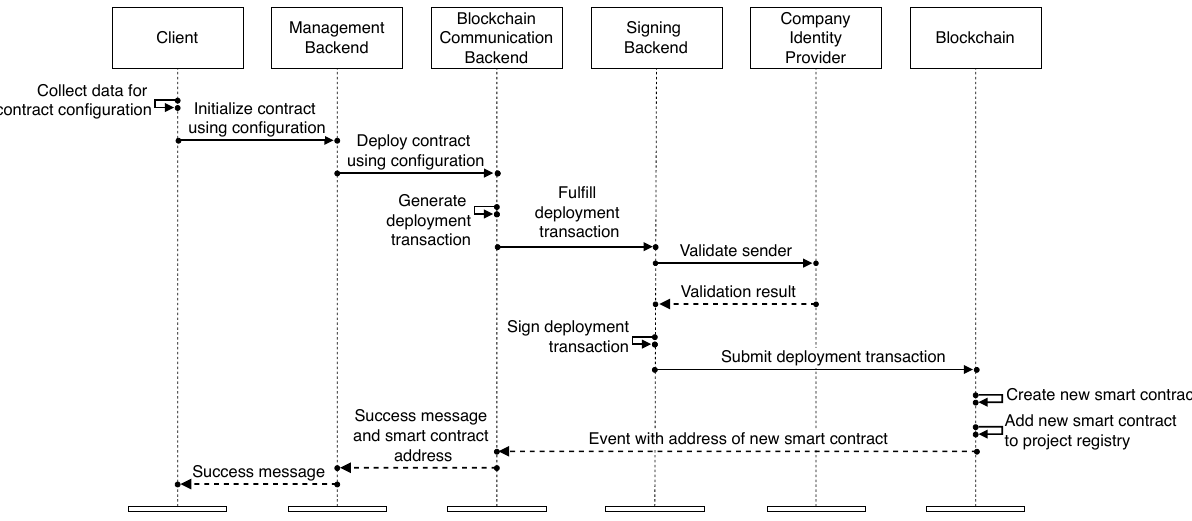
Figure 5. Sequence chart of the generation and deployment of the smart